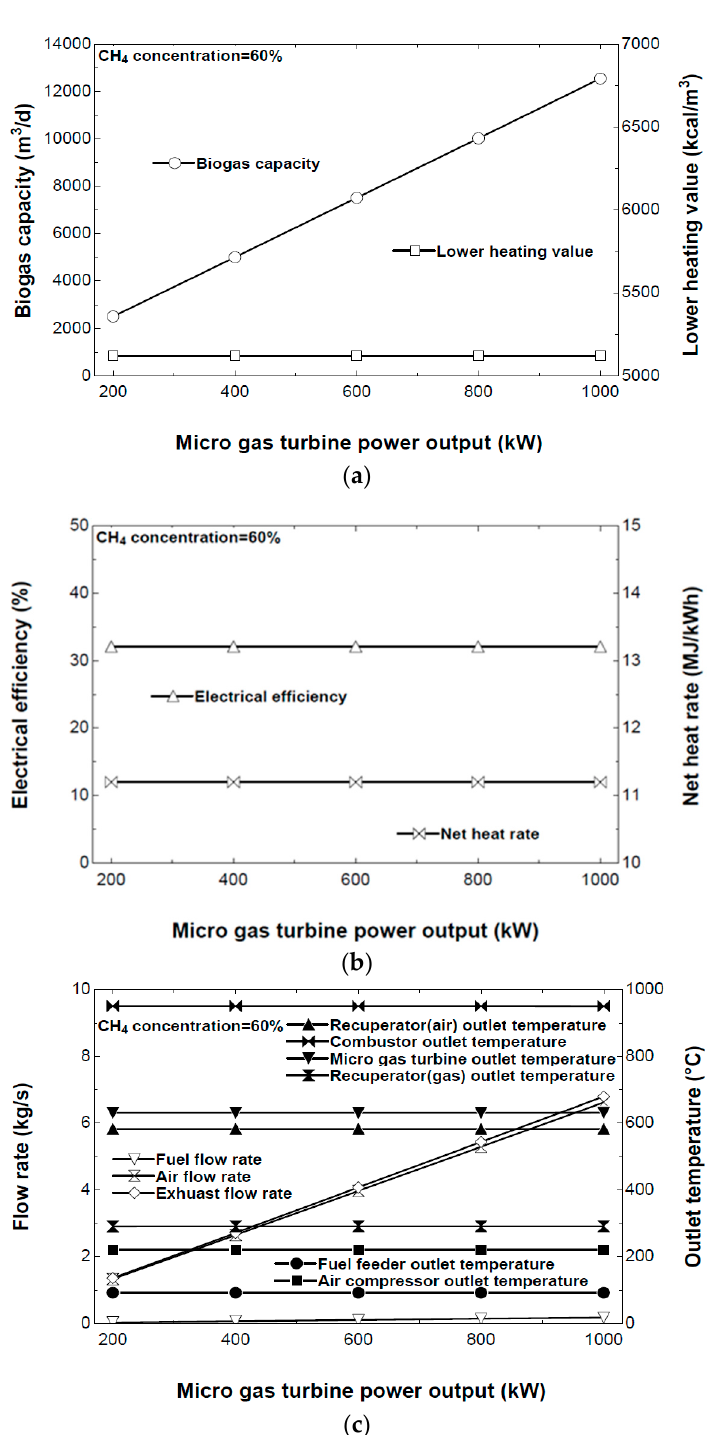
Figure 3. The effect of different sizes of the micro gas turbines on the required operating conditions. ( a ) The biogas capacity per day and the lower heating value of the biogas; ( b ) The electrical efficiency and the net heat rate of the MGT; ( c ) The mass flow rate and the outlet temperature for the streams in the MGT.